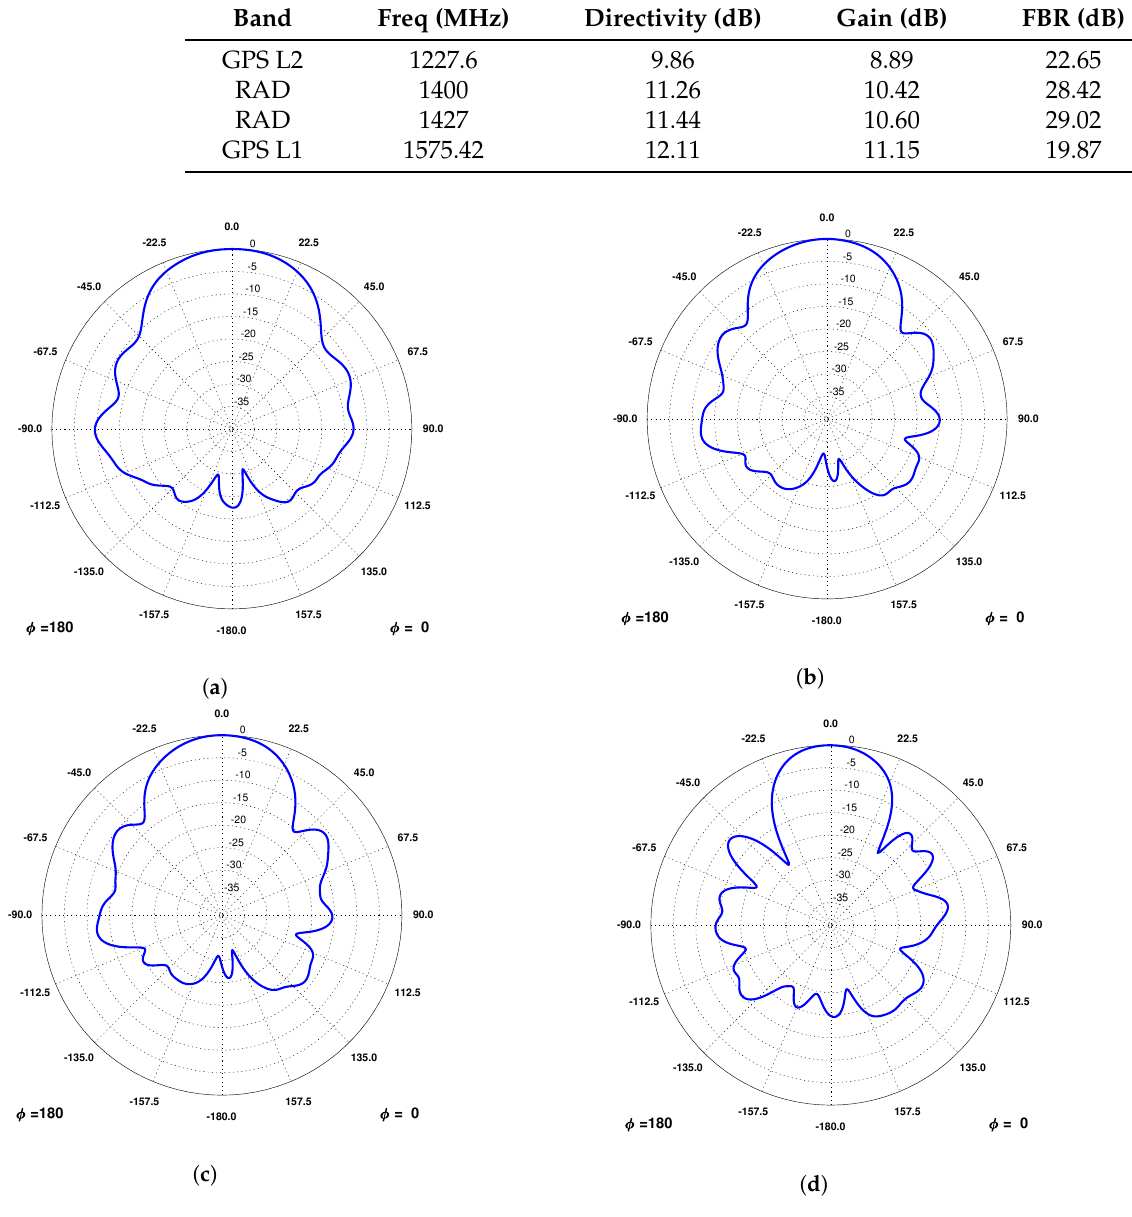
Figure 15. Radiation patterns measured in an Anechoic Chamber from the NADS Flight Model. ( a ) Radiation at 1227.6 MHz. ( b ) Radiation at 1400 MHz. ( c ) Radiation at 1427 MHz. ( d ) Radiation at 1575